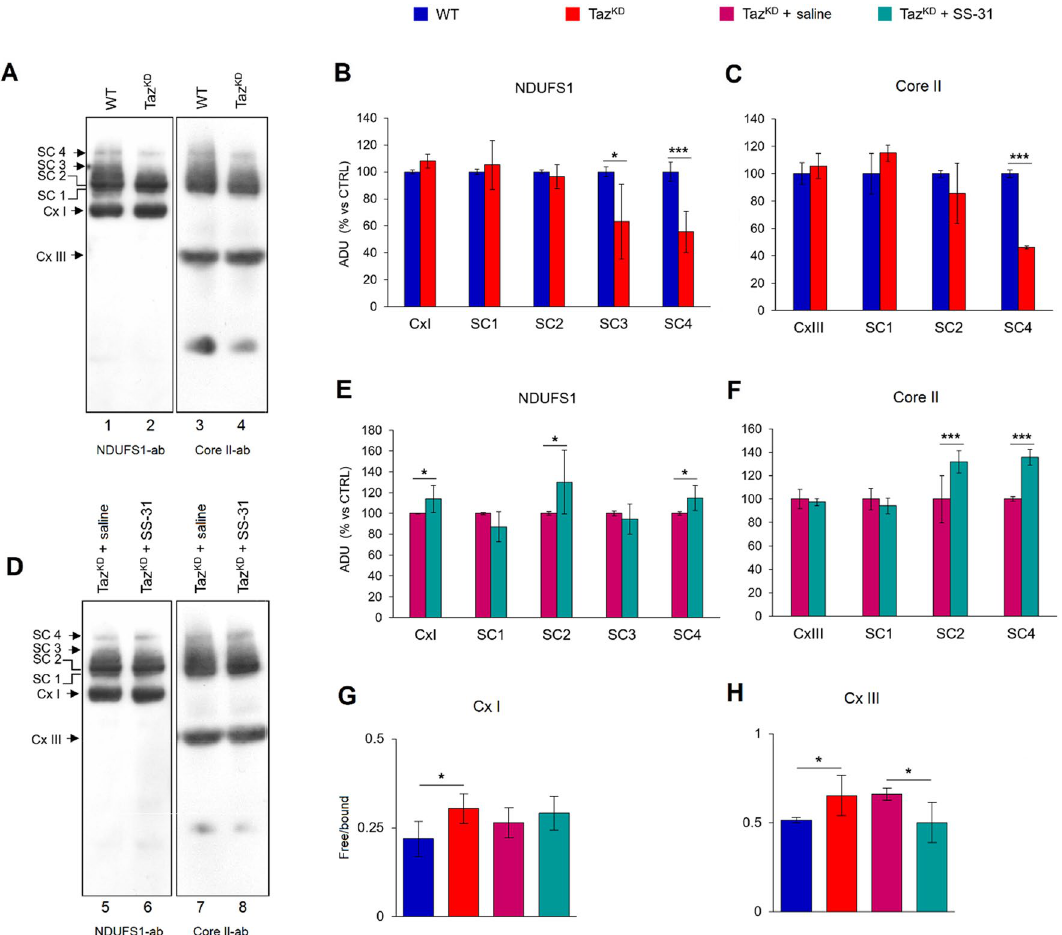
Figure 5. Respiratory chain supercomplex organization analysis. Isolated cardiac mitochondria were separated by BN-PAGE, transferred onto PVDF membrane, and subjected to western blotting analysis with specific antibodies, as indicated. Supercomplexes (SC4, SC3, SC2, and SC1) containing complex I and complex III in various amounts are shown. Complex I (Cx I) and complex III (Cx III) are also identified as monomers ( A , D ). Protein levels estimated by band densitometry ( B , C , E , F ) in Taz KD and Taz KD + SS-31 are expressed as percentages vs WT and Taz KD + saline, respectively. Histograms G and H display the percentage of ADU of immune-revealed bands in free complexes and in supercomplexes in each lane. All histograms show the mean values ± SD (n = 4/group). Statistically significant differences are indicated: Student’s t-test (**p < 0.01, *p <